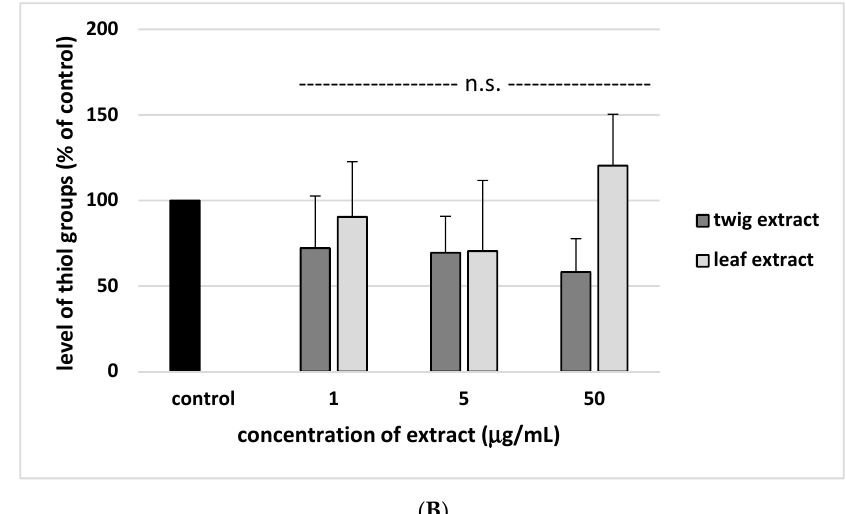
Figure 4. Twig and leaf extract (1, 5 and 50 µg/mL; 30 min) on the level of thiol groups in glutathione (GSH) fraction (A) and protein fraction (B) isolated from blood platelets. Data represent mean ± SE of 3 (for GSH) and 4 (for protein fraction) healthy volunteers (each experiment done in triplicate). In these experiments, the level of GSH fraction in control sample (positive control – blood platelets not treated with plant extract) was 5.7 ± 0.8 nmol GSH/mL of platelets, and was expressed as 100% (A); the level of thiol groups in protein fraction in control sample (positive control – blood platelets not treated with plant extract) was 112.4 ± 17.4 nmol GSH/mL of platelets, and was expressed as 100% (B). None of three different concentrations of the tested extract (1, 5 and 50 µg/mL) had a statistically significant effect compared to controls ( p > 0.05 (n.s.)).